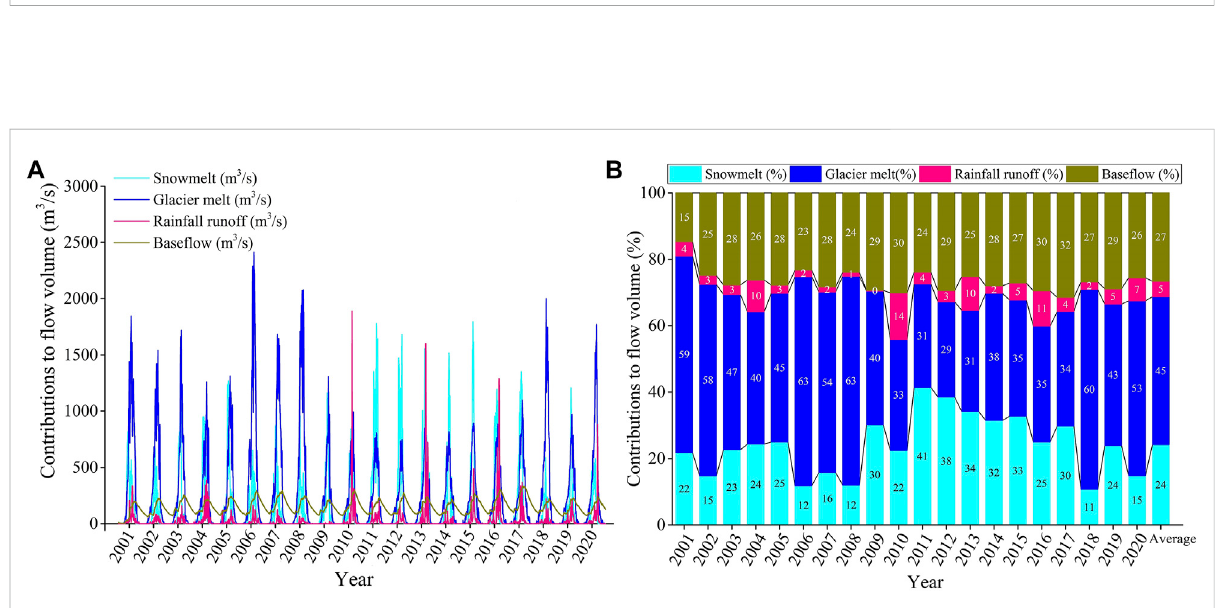
FIGURE 10 (A) Annualvariations insimulated runoff components from2001 to2020 and, (B) Relativecontribution ofrunoff componentsto stream fl owsat the annual time